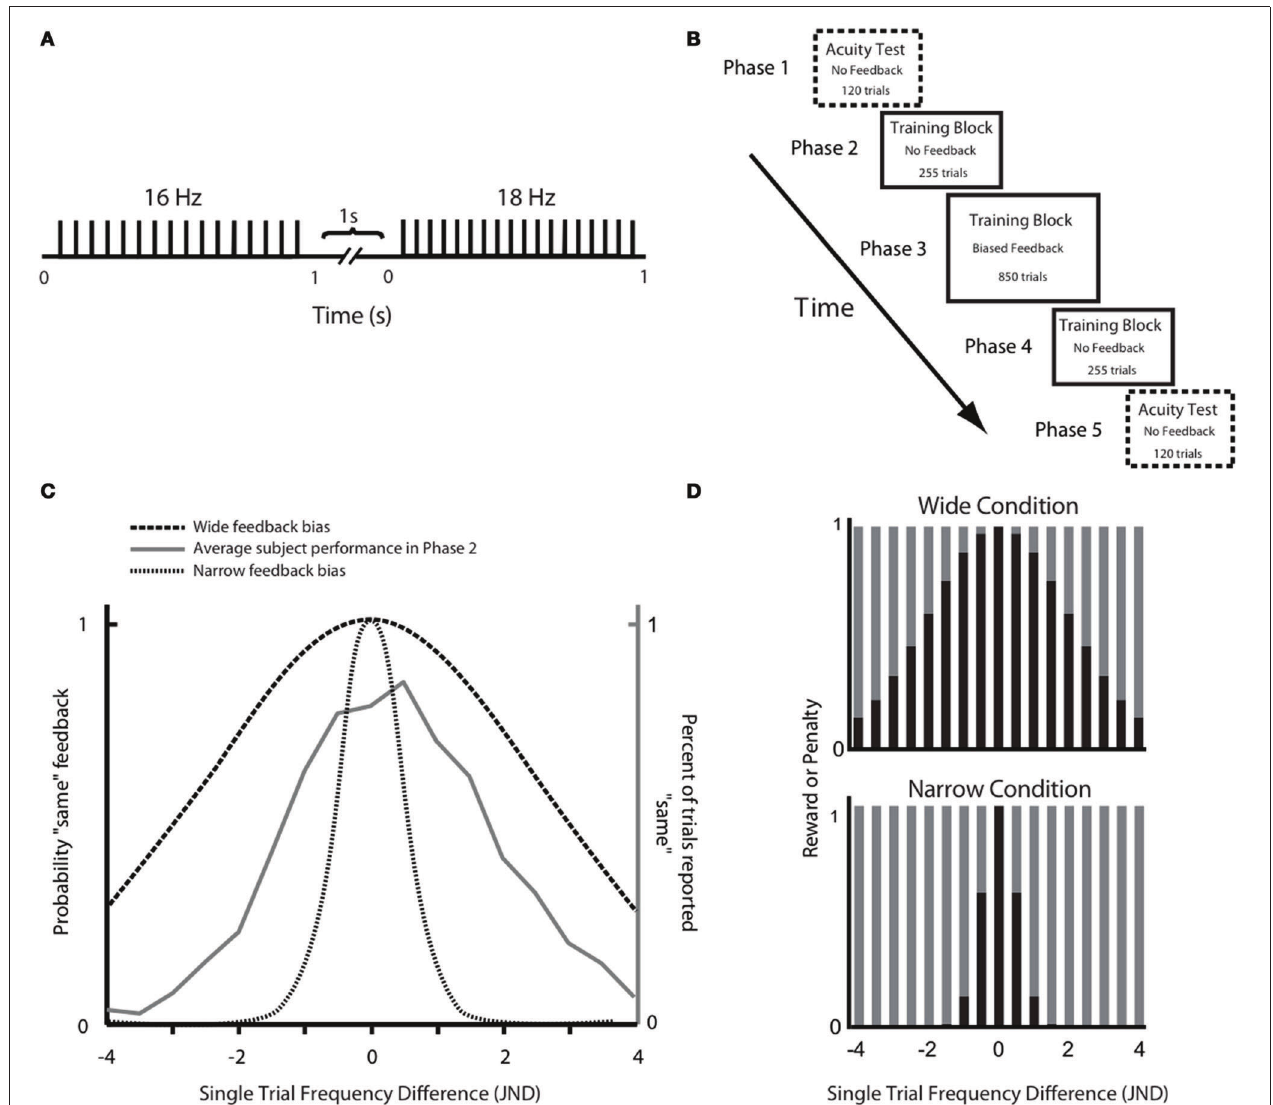
FIGURE 1 | Experimental paradigm. (A) Schematic representation of a stimulus pair. Each vertical bar indicates a 2.5ms half-sinusoidal deflection by the piezoelectric stimulator. Stimulus frequency was determined by the peak-to-peak inter-deflection interval. In acuity tests [Phases 1 and 5; see panel (B) ] the first and second stimuli were both 1s long. In the training session (Phases 2, 3, and 4), the first and second stimuli were 1 and 2s long, respectively. (B) Sequence of phases. For each phase, the presence or absence of feedback is given as well as the number of trials. (C) Comparison of Wide and Narrow feedback distributions to average subject response curve. The gray line shows, for Phase 2, the proportion of trials in which subjects, on average, reported two stimuli to be “same” as a